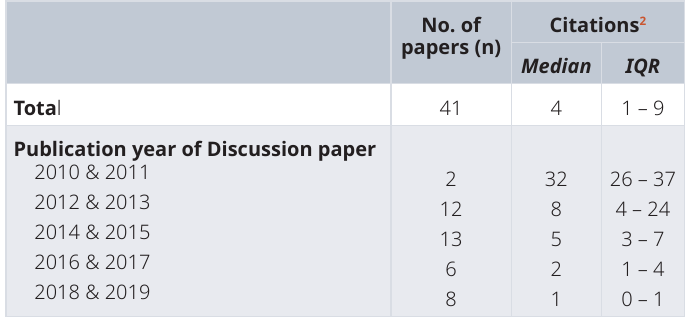
Table 2. An overview of citations resulting from SORT IT viewpoint papers 1 according to their year of publication.